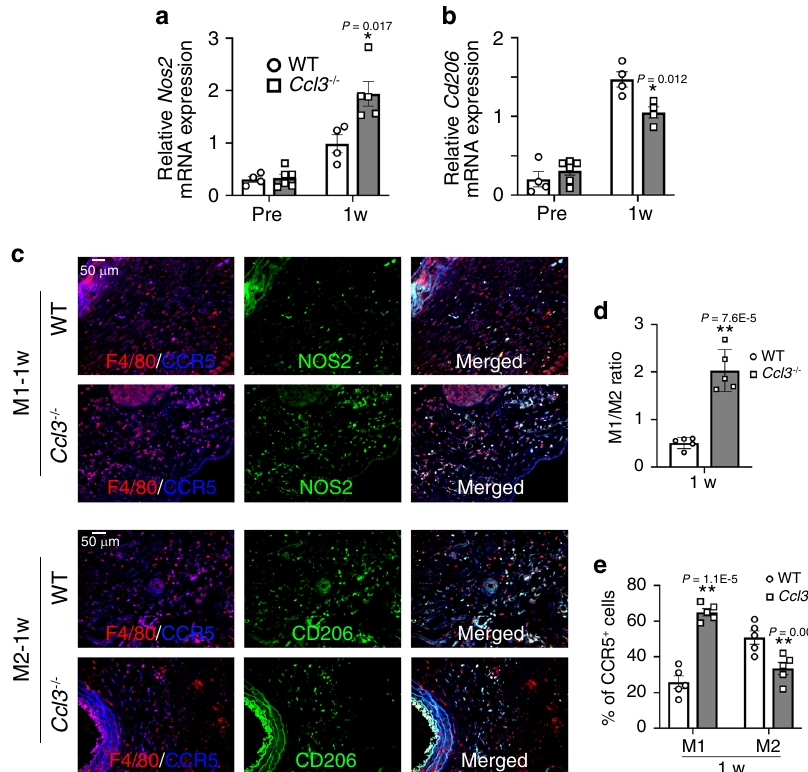
Fig. 6 Determination of M1- and M2-like phenotypes in macrophages in aortic tissues of WT and Ccl3 − / − mice after CaCl 2 treatment. a , b Intra-aortic gene expression of a Nos2 (Pre: n = 4 in WT, n = 6 in Ccl3 − / − ; 1 week- n = 4 in WT, n = 5 in Ccl3 − / − ) and b Cd206 (Pre: n = 4 in WT, n = 6 in Ccl3 − / − ; 1 week- n = 4 each in WT and Ccl3 − / − ). ** P < 0.01; * P < 0.05, vs. WT mice. c Triple-color immuno fl uorescence analysis of F4/80 + CCR5 + NOS2 + M1 macrophages and F4 / 80 + CCR5 + CD206 + M2 macrophages in the AAA tissues of WT and Ccl3 − / − mice after CaCl 2 application. Representative images from fi ve independent experiments are shown. Scale bar, 50 µ m. d The ratio of M1 to M2 macrophages in WT and Ccl3 − / − mice ( n = 5 each in WT and Ccl3 − / − ). ** P < 0.01, vs. WT. e The percentage of CCR5 + cells in M1 or M2 macrophages from WT and Ccl3 − / − mice after CaCl